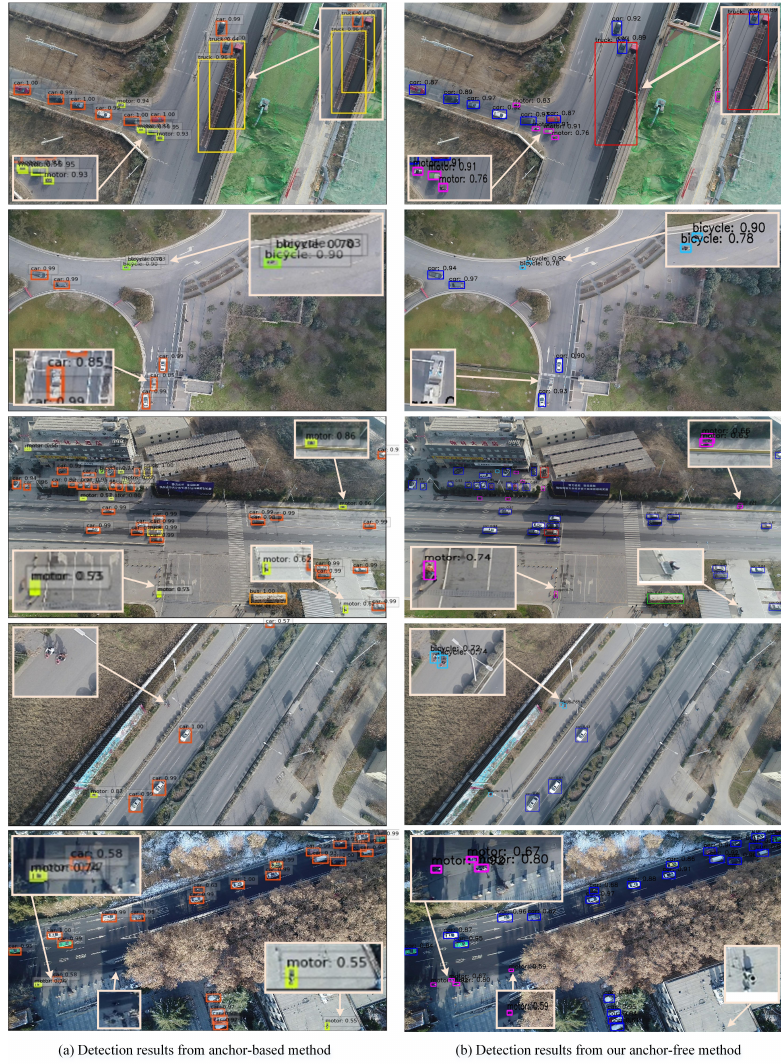
Figure 5. Qualitative results comparing the proposed anchor-free method with the anchor-based